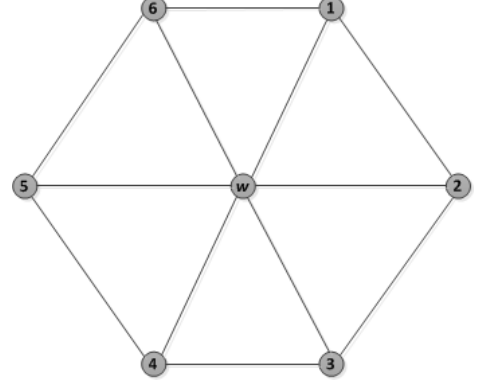
Figure 9. Network design.